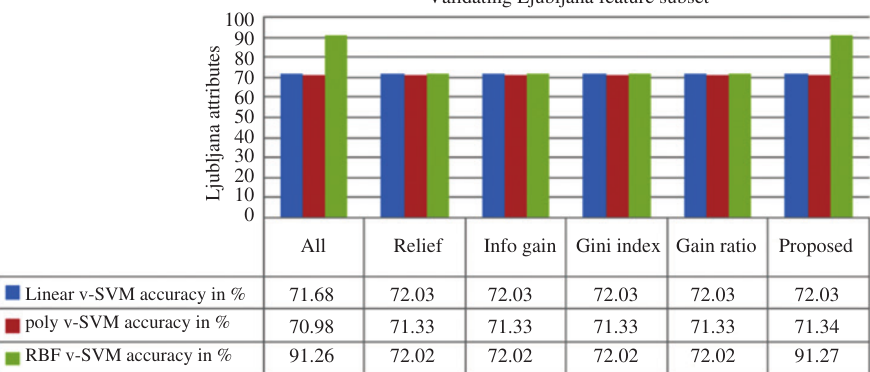
Figure 3: Validating the Performance of Ljubljana Feature Subset.